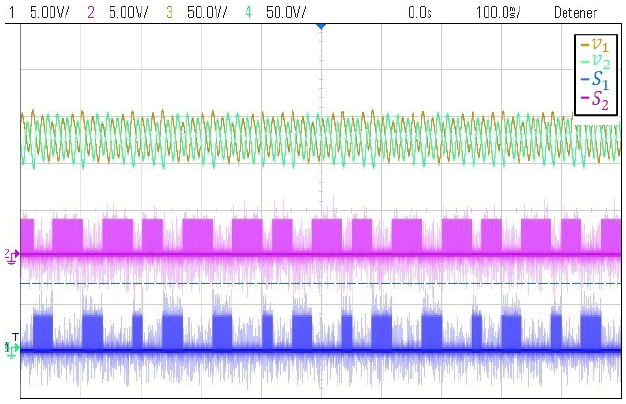
Figure 20. Waveforms of v 1 , v 2 , S 1 and S 2 for I s =